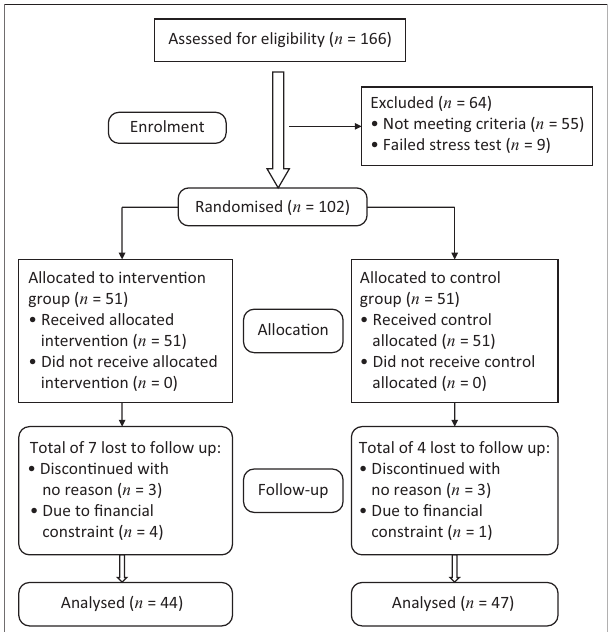
FIGURE 1: Recruitment and retention: Brief peripheral neuropathy screening